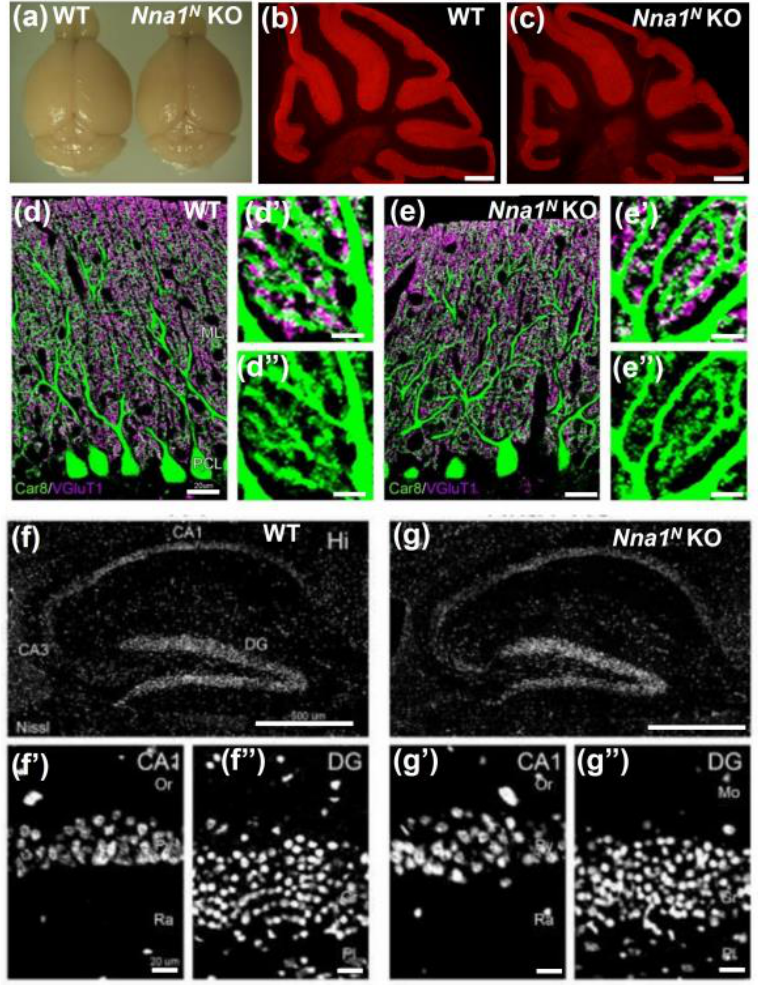
Figure 2. Immunohistochemical observation in the cerebellum and hippocampus of Nna1 N KO mice. ( a ) Macro image of the brains from Nna1 N KO mice and WT mice in the adult age (n = 3 mice in each genotype). No significant atrophy on the parasagittal image of the cerebellum was observed between Nna1 N KO and WT mice. ( b , c ) Calbindin-D28K IHC on parasagittal sections (n = 3 mice in each genotype). No significant expression difference was observed in the cerebellum between Nna1 N KO and WT mice (n = 3 mice in each genotype). ( d , d′ , d″ ) and ( e , e′ , e″ ) Car8 and VGluT1 double IHC also showed no significant difference between KO and WT mice. ( f , f′ , f″ ) and ( g , g′ , g″ ) Nissl staining on parasagittal sections (n = 3 mice in each genotype). No significant morphological and cell number difference was observed between Nna1 N KO and control mice. Scale bars: 20µm in ( d , e , f′ , f″ , g′ , g″ ), Scale bars: 0.5mm in ( b , c , f , g ), Scale bars: 5 µm in ( d ′ , d″ ). 2.3. Nna1 N KO Mice Are Impaired in Emotional and Memory Learning In the open-field test, Nna1 N KO mice were more hyperactive and spent much more time in the center of the open-field area compared with WT mice (Figure 3a – c), while there was no significant difference in their movement speed (Figure 3d). In the next light-dark transition test, Nna1 N KO mice made a more significant number of transitions between the light and dark areas than WT mice (Figure 4a – c). However, there was no significant dif- ference in the total distance traveled (Figure 4b,d). There was no significant difference in the time spent in the light area of the box between WT and Nna1 N KO mice, but Nna1 N KO mice seemed to spend more time in the dark area with more motility than the wild-type mice, indicating a trend of hyperactivity (Figure 4b,e). Furthermore, we performed the elevated plus-maze test to evaluate anxiety (Figure 5a). Although there was no significant difference in the total distance traveled (Figure 5b), Nna1 N KO mice spent more time in the open arm of the maze and the center of the crossed arms than WT mice, showing less anxiety in Nna1 N KO mice (Figure 5c,d).